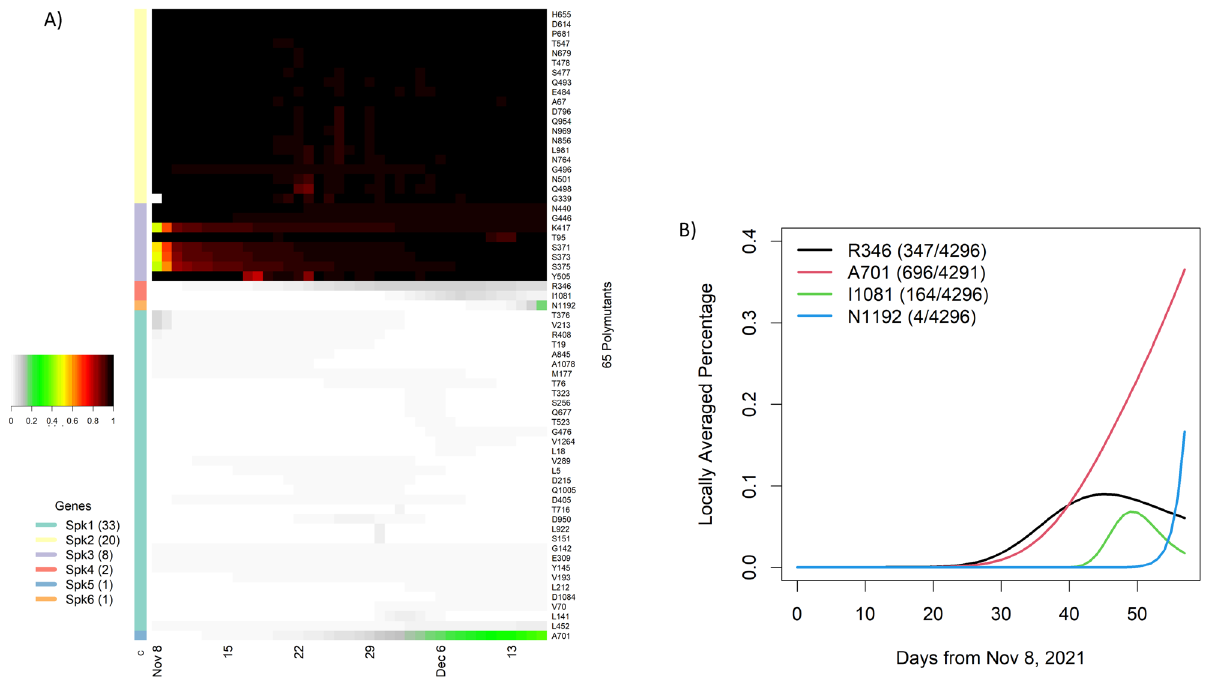
Figure 3. Temporal analysis of polymutants in spike protein: ( A ) a heatmap representation of dynamic expansions/subtractions of 65 polymutants, in which locally averaged mutation percentages of every polymutant over time are shown in a row and is correspondingly colored from gray to dark red (color legend on the left side). By similarities/dissimilarities of their temporal patterns, all polymutants are clustered to six clusters (Spk1, …, Spk6), and numbers of polymutants in each cluster are indicated in bracket. ( B ) Four polymutants with positive trajectories (in cluster Spk4, 5 and 6) are selected to illustrate their temporal patterns. Heatmaps and temporal plot are generated by heatmap package and plot function in statistical R software 3